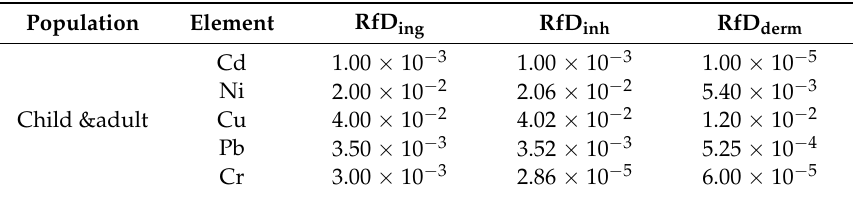
Table 5. Non-carcinogenic exposure reference doses of heavy metal in different exposure pathways